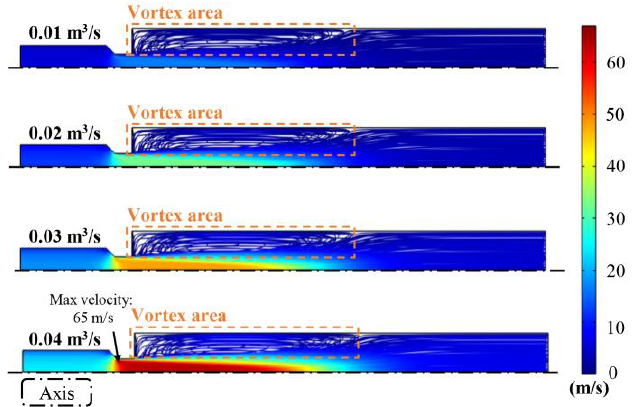
Figure 6. Velocity streamlines in the differential motion assembly with different inlet flow rates (0.01~0.04 m 3 /s); the fluid viscosity was set as 100 mPa·s.